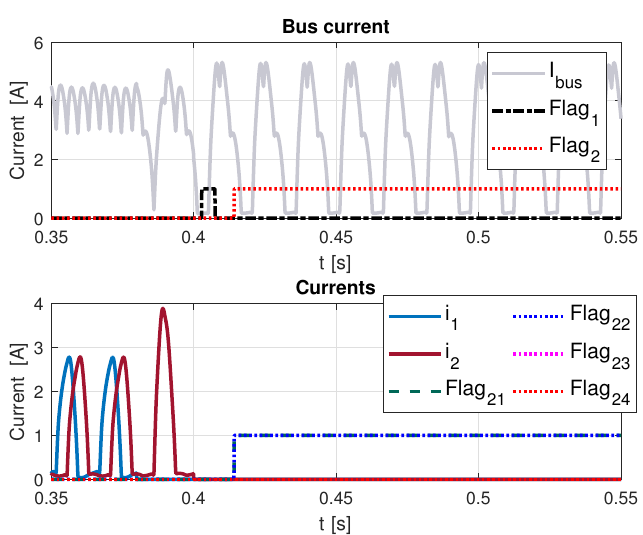
Figure 8. One-phase fault, fault phase 1.